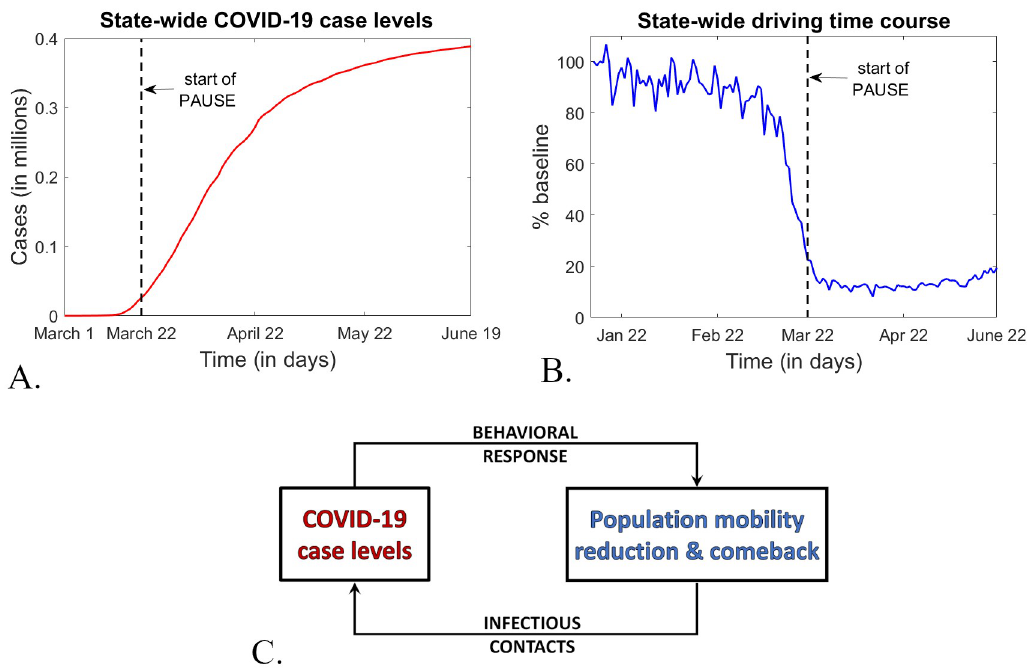
Fig 1. Epidemic and driving time courses in the state of New York, and their potential coupling. A. Total case load, from March 1, 2020 (the day of the first confirmed positive case in the state) until June 20, 2020 (the end of our study) . B. Driving time course, as reported by Apple (as a % baseline change), from January 13, 2020 (the baseline value) until June 20, 2020 (the end of our study) . C. Two potential mechanisms that describe bidirectional coupling between epidemic incidence and population mobility during an epidemic outbreak. One aspect of the population behavioral response to increasing case levels is making more careful decisions around leaving the residential space (decisions which may vary even in the presence of general mobility reduction mandates). In turn, reducing mobility affects case levels by reducing the potential infectious contacts within the community .